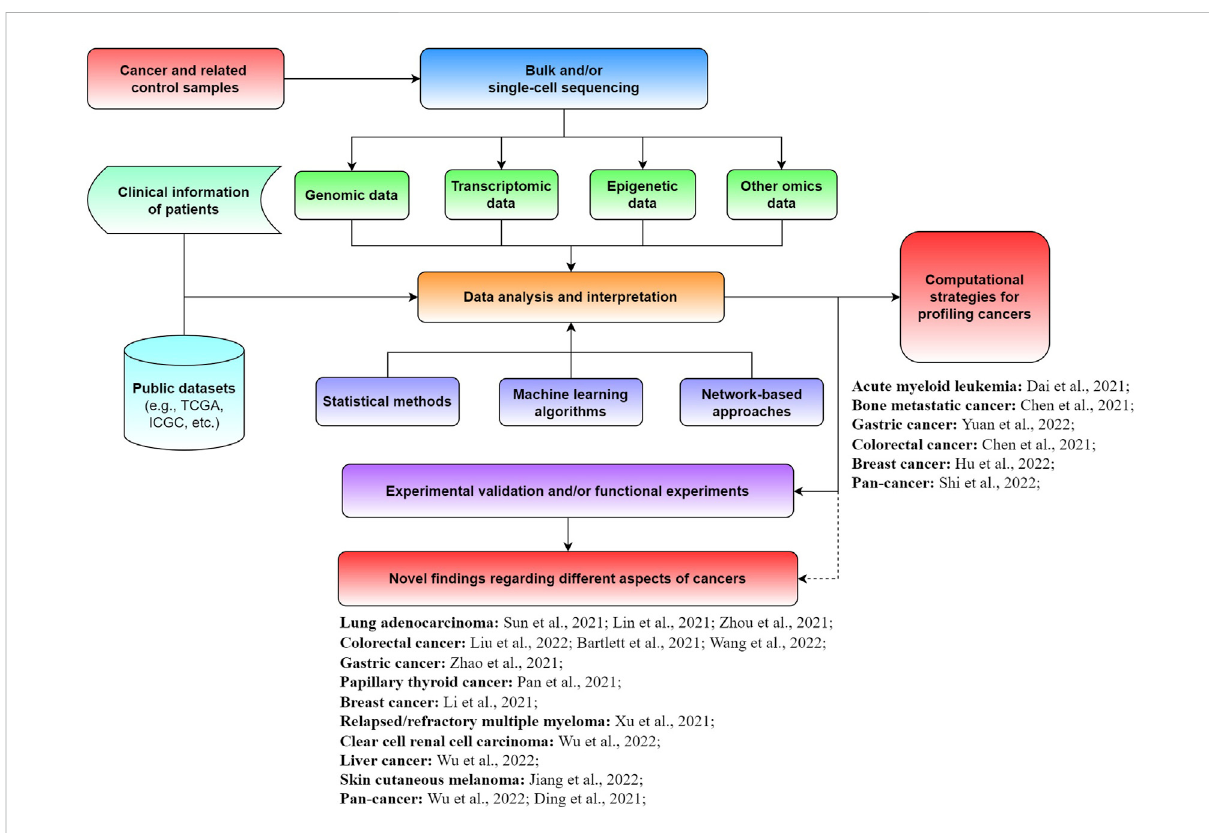
FIGURE 1 Schematic view of the application of sequencing technologies and bioinformatics approaches for cancer-related studies.